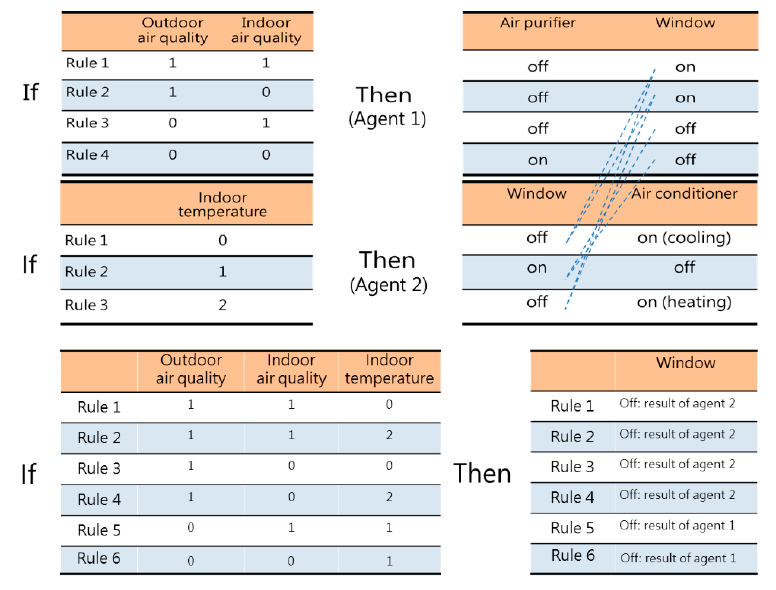
Figure 12. Rule table design, analysis of possibilities of conflict, and conflict resolution methods.